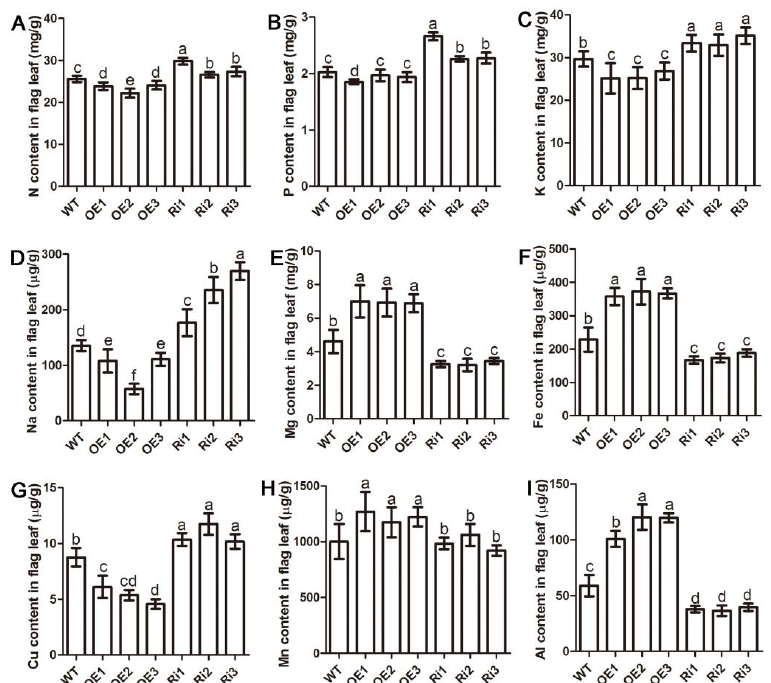
Figure 5. Differentially expressed genes among the OE line, Ri line, and WT. ( A ) Venn map of differential genes among the overexpressing (OE) line, RNA interference (Ri) line, and wild-type (WT). ( B ) 13 differentially expressed genes among the OE line, Ri line, and WT. Abscissa indicates a log2 fold change, and ordinate indicates the locus name of the genes.